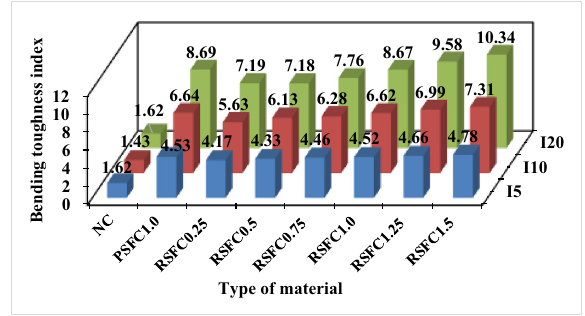
Figure 19: Flexural toughness index of